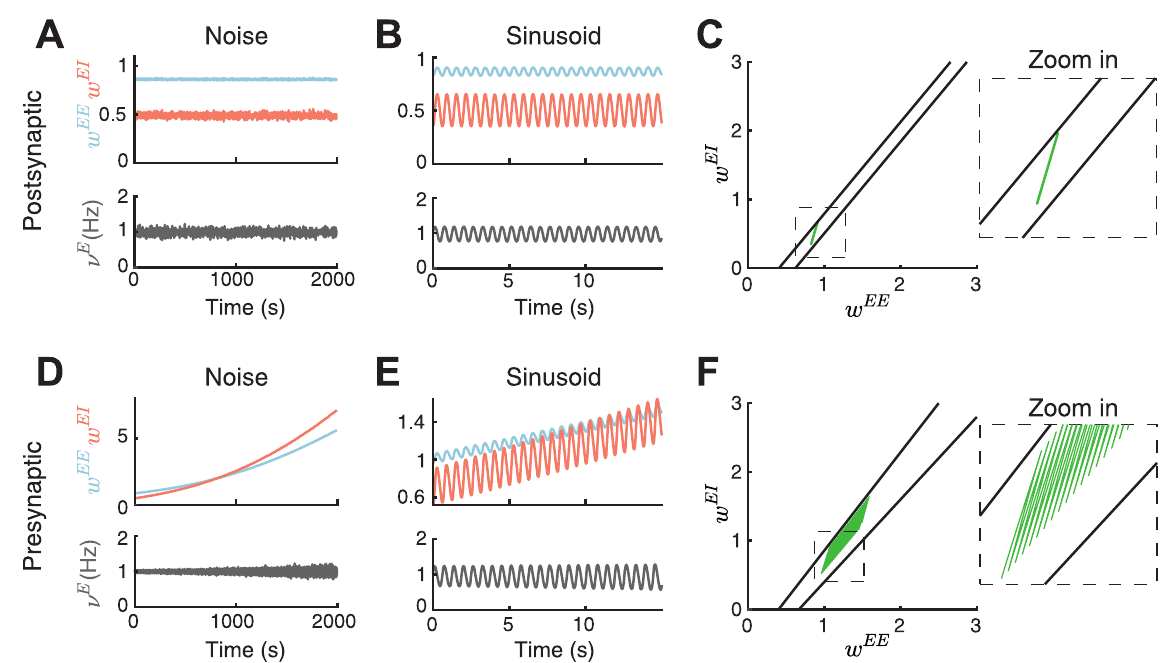
Fig 6. Performance of the nonlinear inhibitory plasticity rule under varying presynaptic input and postsynaptic firing rate. A . Adding noise to the postsynaptic firing rate. Top: E-to-E ( w EE , blue) and I-to-E ( w EI , red) as a function of time. Bottom: Postsynaptic rate dynamics ( ν E , gray) as a function of time. B . Same as A but after adding a sinusiodal input to the postsynaptic firing rate. C . Left: The line attractors in the w EE and w EI phase plane at the maximum and minimum of the postsynaptic firing rate after the addition of sinusoidal input (black lines) and the weight dynamics from B (green). Right: Zoom in of the phase plane. D . Same as A but after adding the noise to the presynaptic input rate. E . Same as B but after using a sinusoid for the presynaptic input rate. F . Same as C but after using a sinusoid for the presynaptic input rate with weight dynamics from E